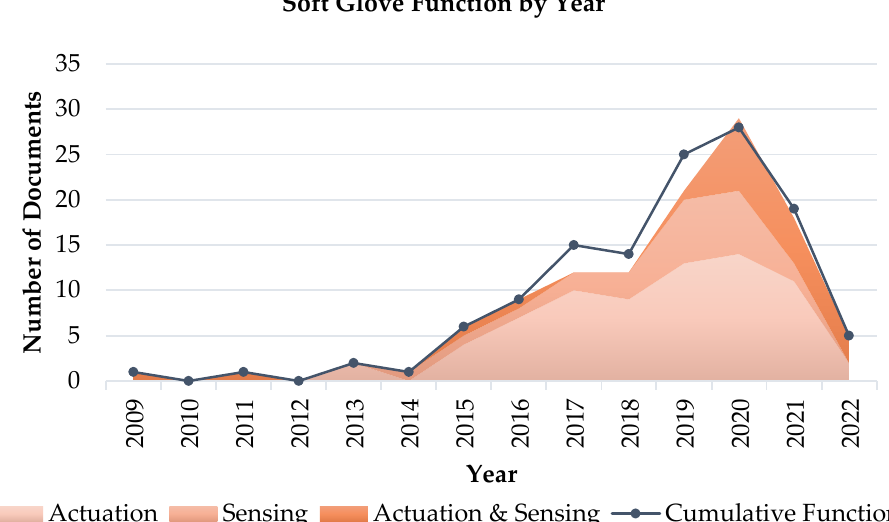
Figure 12. Evolution in time of the soft gloves with respect to the device function. Data are presented in stacked format, with the total amount of documents for each year in black line with dots.